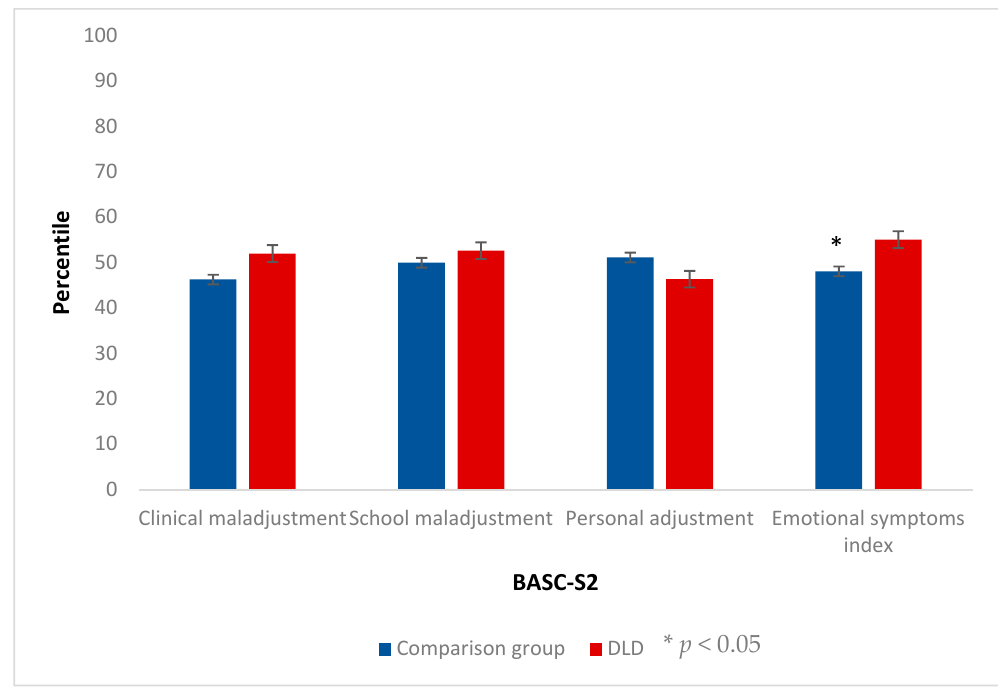
Figure 3. Results for the composite scales of the BASC participant rating scales (S2). The bars represent the means and the error bars represent the standard errors.